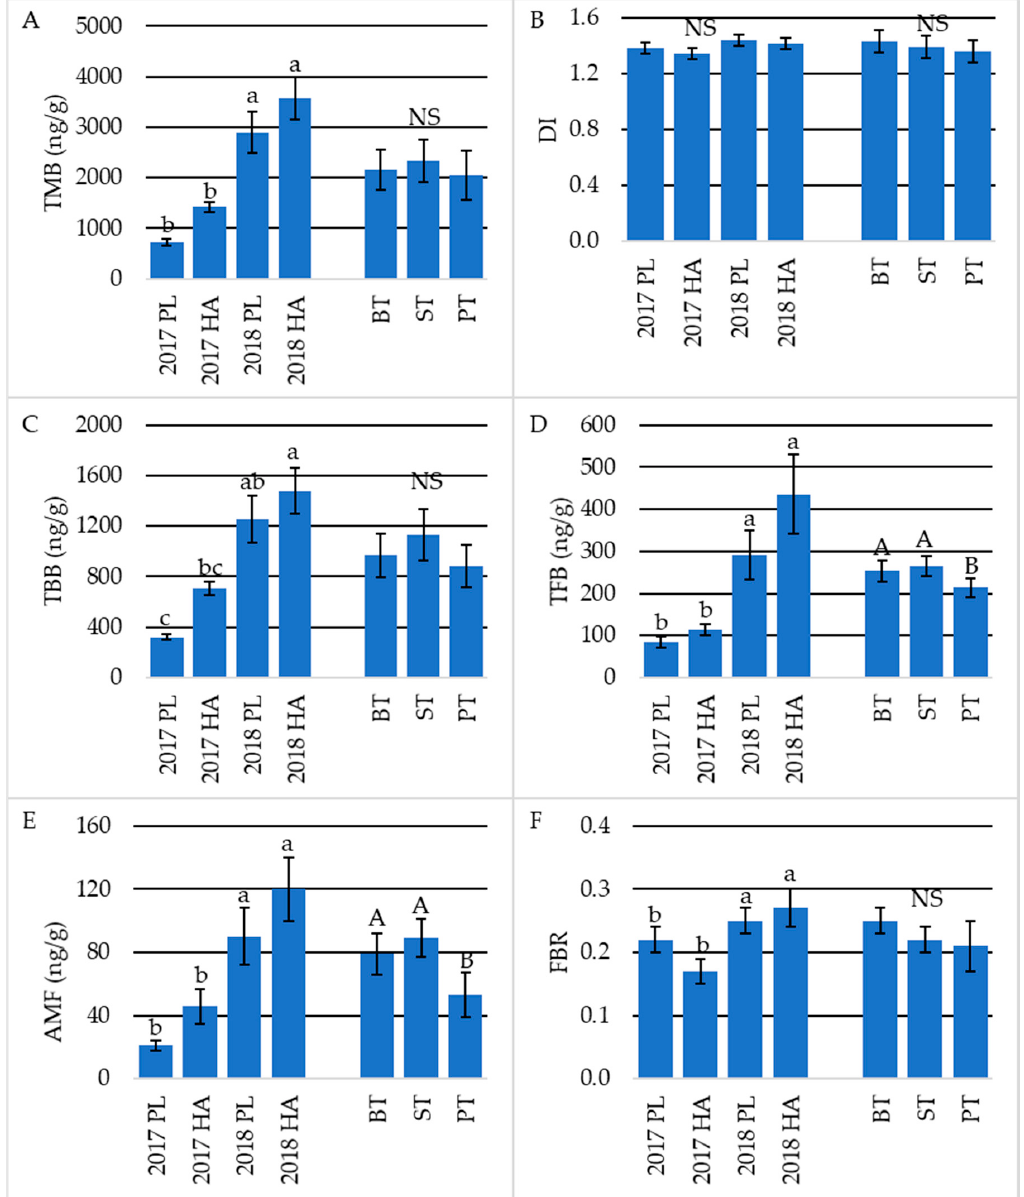
Figure 2. ( A – F ) Soil biological measurements. ( A ) Total microbial biomass (TMB); ( B ) diversity index (DI); ( C ) total bacteria biomass (TBB); ( D ) total fungal biomass (TFB); ( E ) arbuscular mycorrhizae fungi biomass (AMF); ( F ) fungi to bacteria ratio (FBR) as a function of tillage treatments and time in Las Cruces, NM (2017 and 2018). a, b, c, A, B—bars with di ff erent upper or lowercase letters indicate significant di ff erences at p < 0.05 for a given measurement; NS—no statistical significance, PL—measurement before planting; HA—measurement at harvest; BT—bed tillage; ST—strip tillage; PT—plow tillage; error bars indicate the standard error of mean for respective